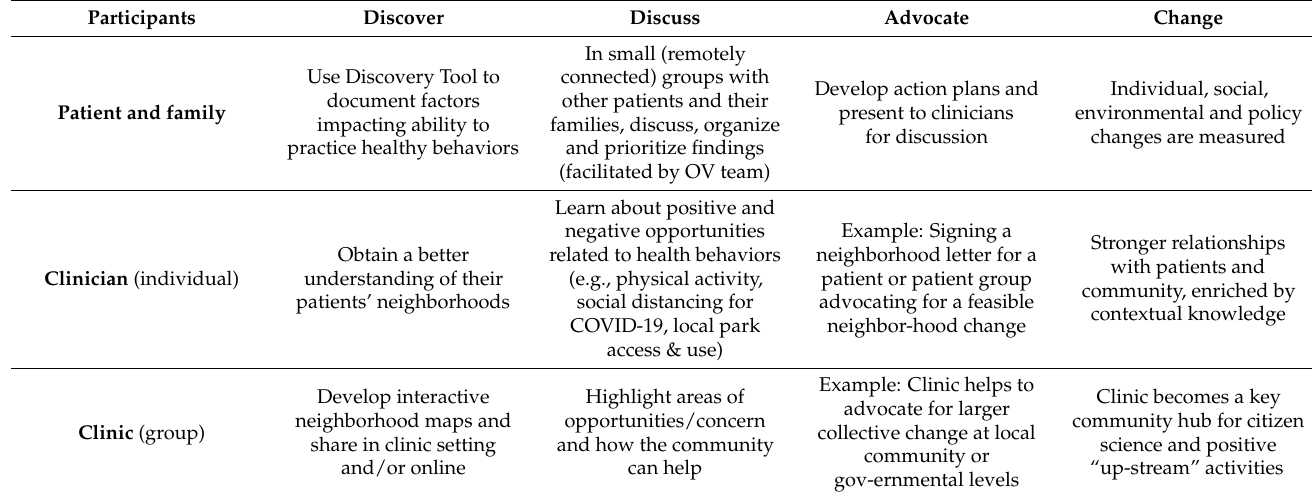
Table 2. Examples of how the Our Voice citizen science model can be adapted to a clinical